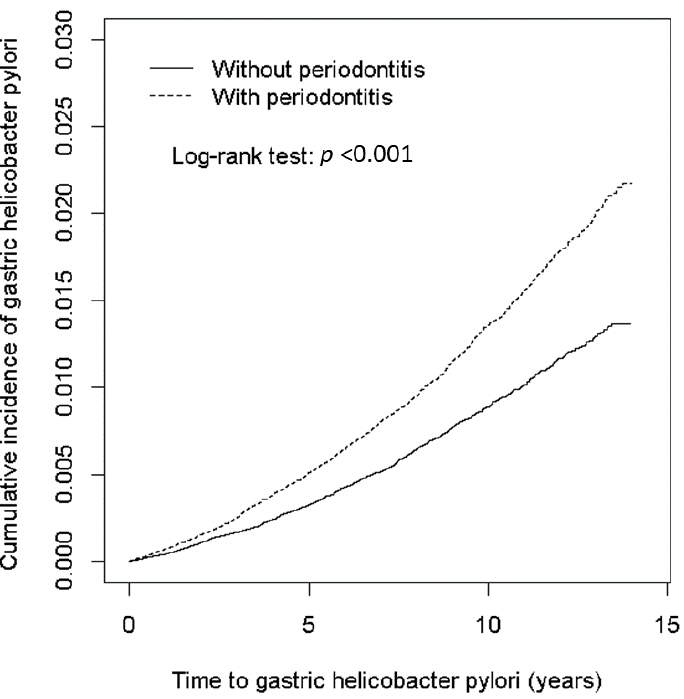
Figure 1. Cumulative risk of gastric Hp compared among in patients with and without periodontitis. Patients with periodontitis had a higher cumulative risk of gastric Hp than those without